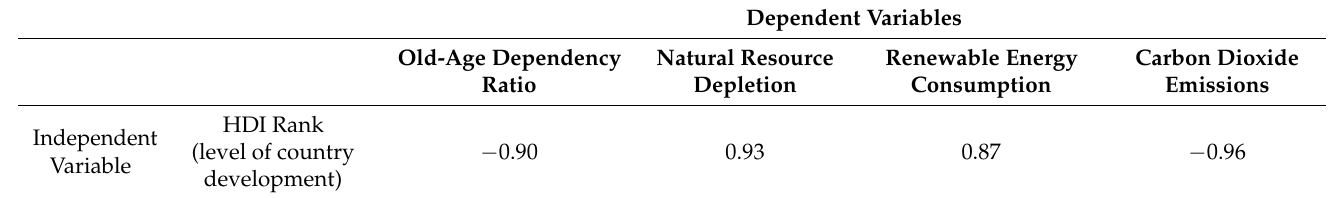
Table 2. Pearson